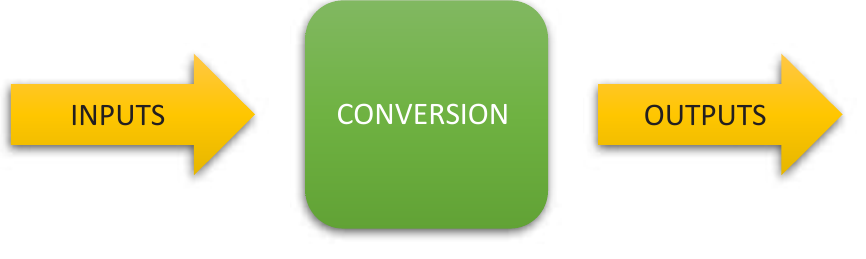
Figure 1. The simple system